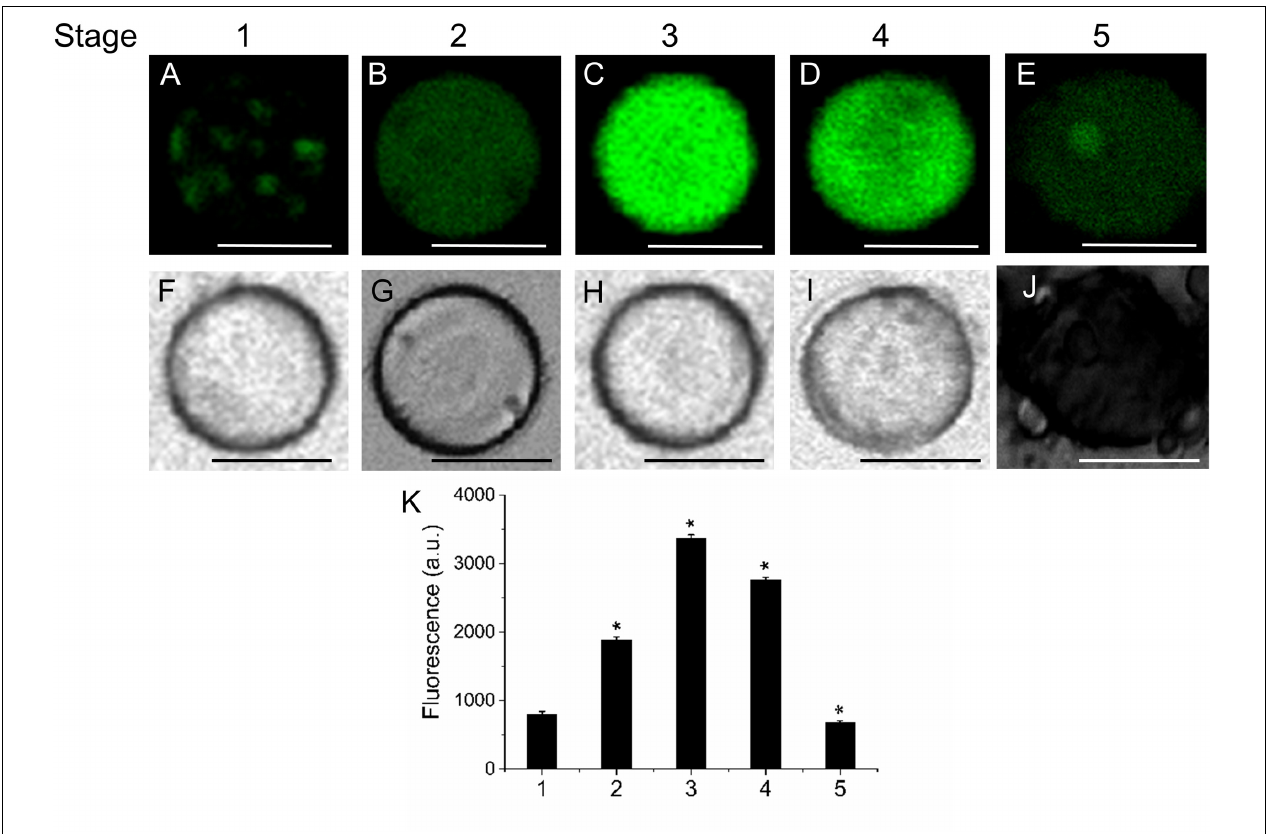
FIGURE 2 | Lipid distribution in live protoplasts from olive fruit during development. (A–E) Bodipy stained protoplasts from the olive fruit at different developmental stages compared to the white-light image (F–J) . Olive fruit were sampled at 1 (green with completed pit hardening), 2 (green with peak of cell expansion), 3 (onset of ripening), 4 (veraison), and 5 (ripe) stages of development. (K) Quantification of Bodipy fluorescence in live protoplasts from olive fruit at different stages of development. Data from about 20 protoplasts were acquired per sample, and data were compiled using FV10 4.2 software (Olympus). Columns and bars indicate means ± SD, respectively, from five independent experiments. Statistically significant differences from the preceding point based on unpaired Student’s t -test at P < 0.05 are denoted by asterisk. Scale bars are 10 µ